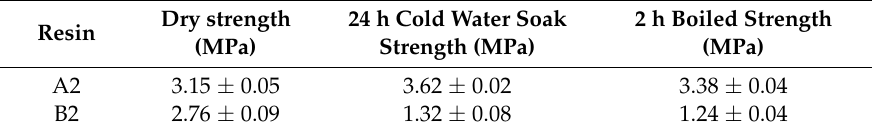
Table 3. Strength results of wood joints bonded with glucose (A2) and sucrose (B2) NIPU resins.